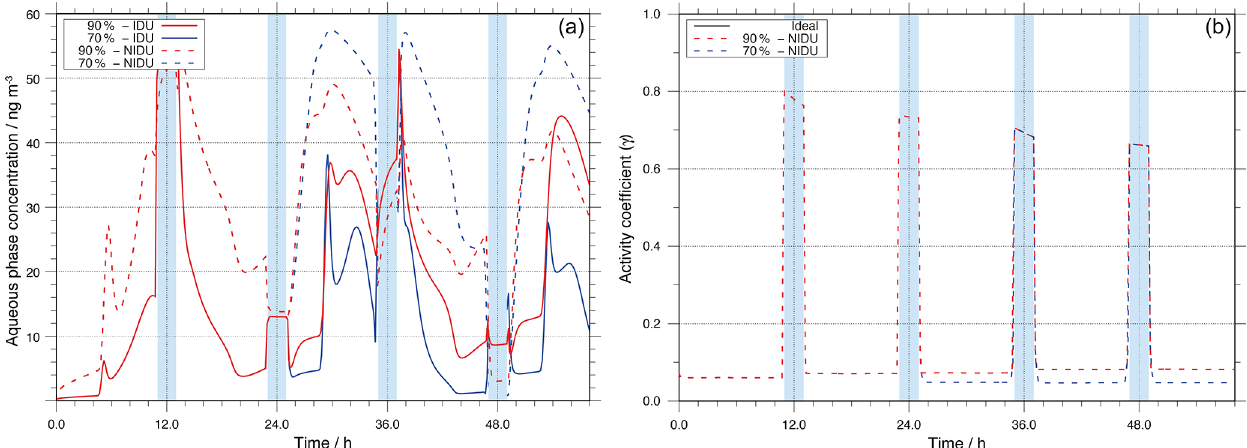
Figure 4. Modelled Fe(II) aqueous-phase concentration in ngm − 3 throughout the modelling time (a) and corresponding time evolution of